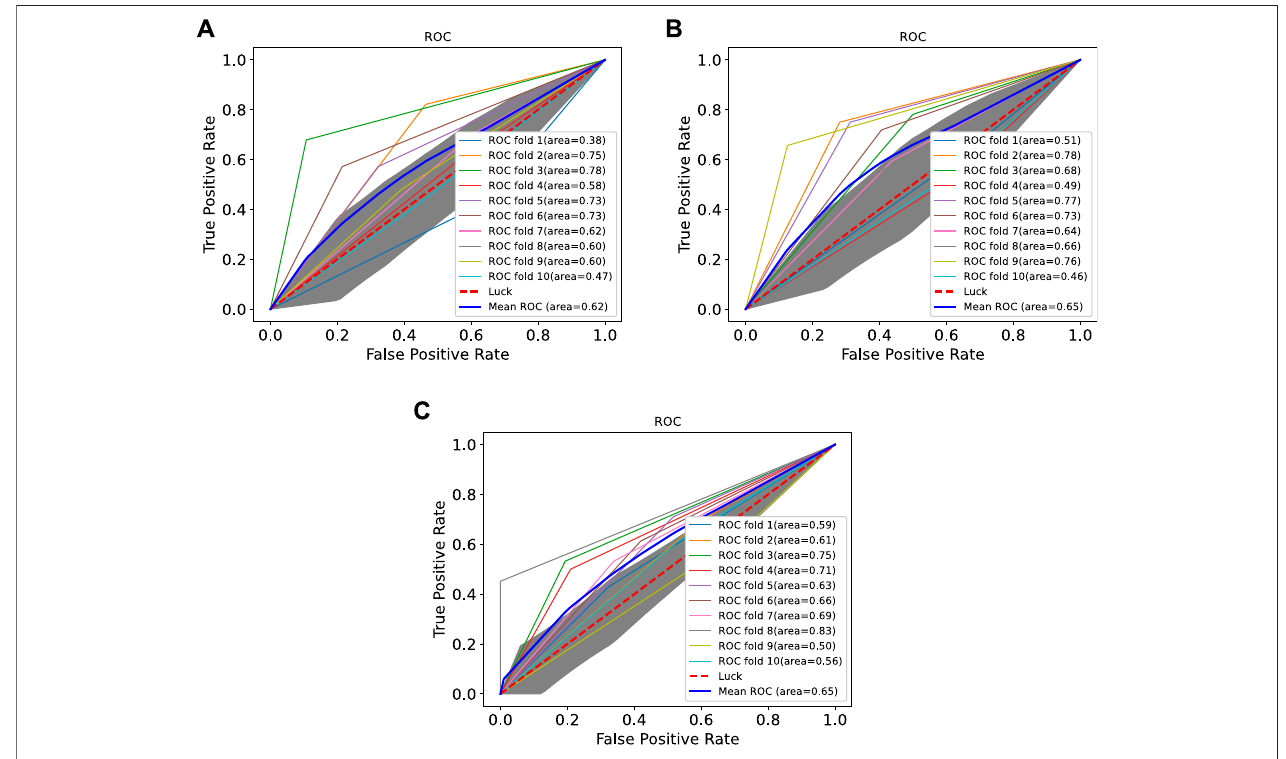
FIGURE 8 | ROC curves on three datasets using GBDT. ROC, receiver operating characteristic.